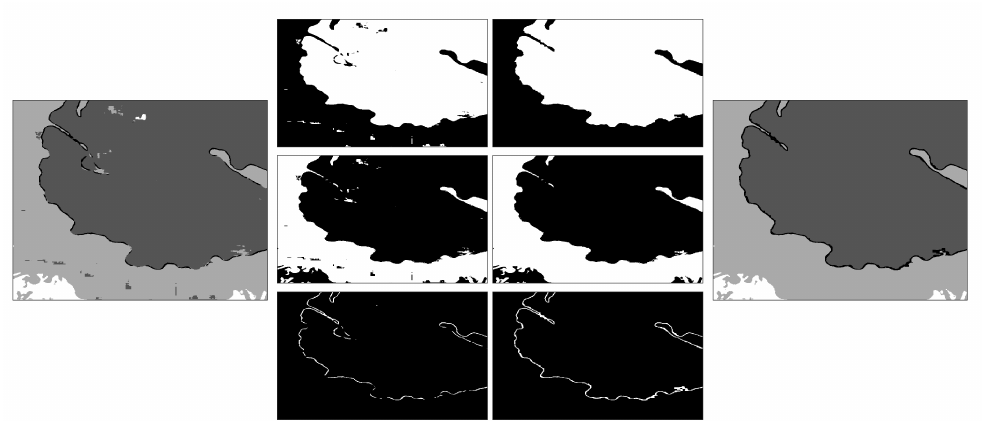
Figure 7. Illustration of the post-processing. The classes corresponding to a small section of one slice of the dataset are shown on the left. On the two central columns, the pre-processing and post- processing are shown per class, from top to bottom, nucleus, cell and nuclear envelope. On the right is the final post-processed region. It can be seen how small misclassifications over the nucleus and cell have been smoothed, and the nuclear envelope improved its